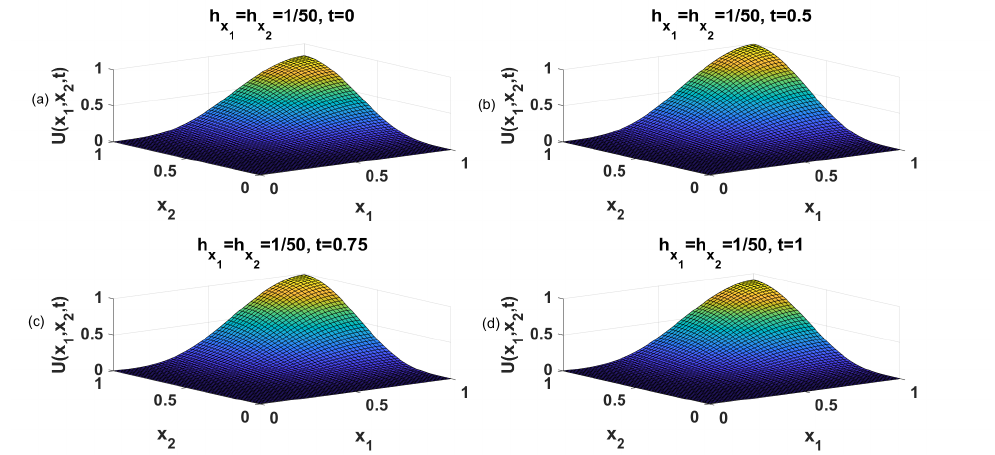
Figure 2. The numerical solutions for Example 2 for different time values ( a : t = 0, b : t = 0.5, c : t = 0.75, d : t =